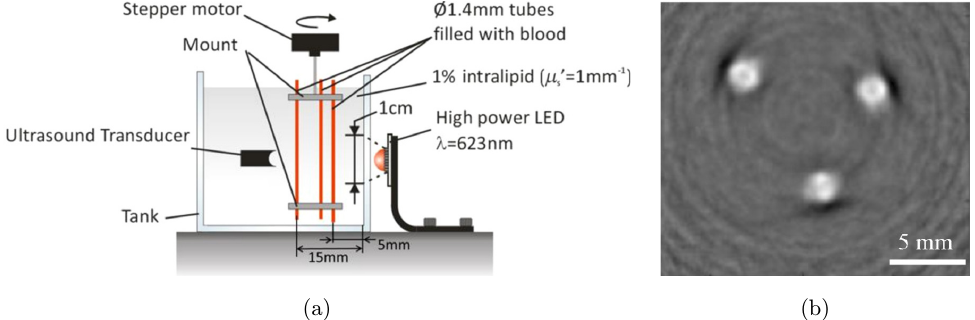
Fig. 10. (a) Schematic of pulsed LED-PAI system and (b) reconstructed photoacoustic image (images adapted from Ref.